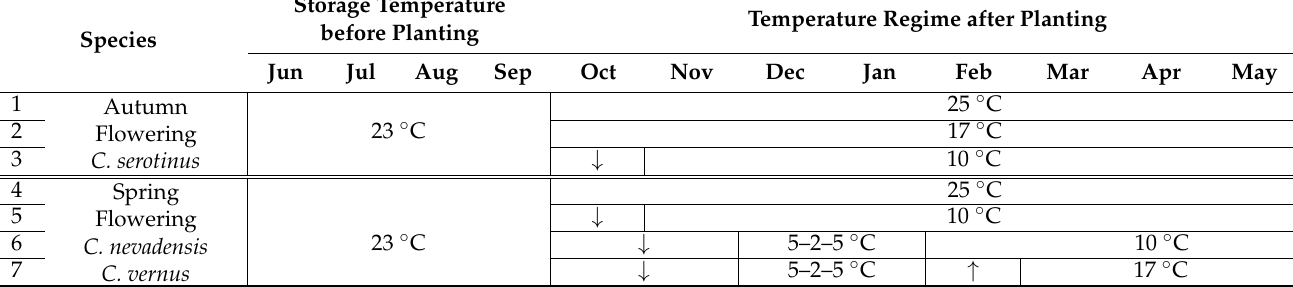
Table 1. Experimental layout of storage and growth conditions of three Crocus species. Corms were harvested in June, stored at constant 23 ◦ C for 2 months and then exposed to various growth conditions. ↓ Progressive decrease in temperature. ↑ Progressive increase in